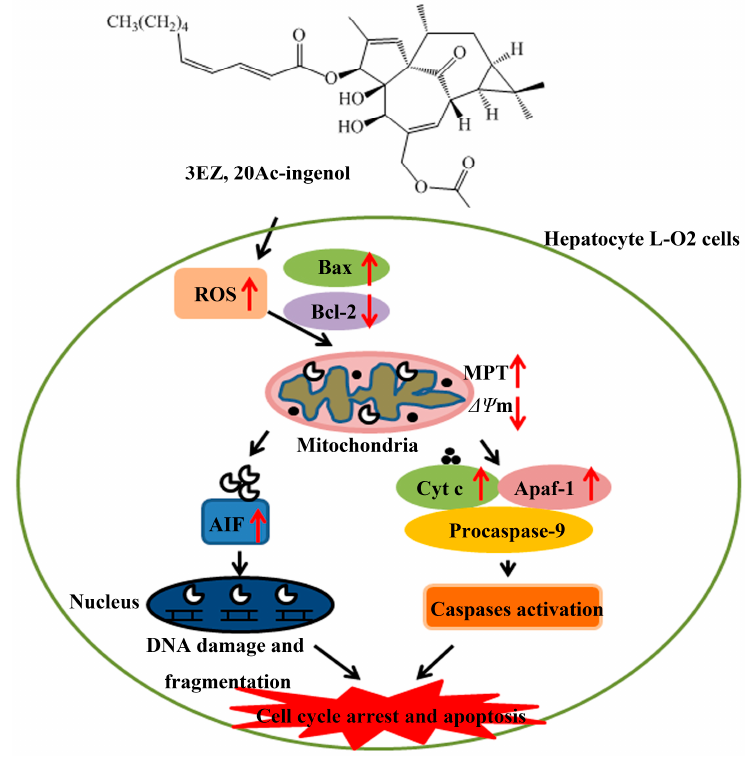
Figure 10. Proposed mechanisms of 3EZ, 20Ac-ingenol-induced cell apoptosis in hepatocyte